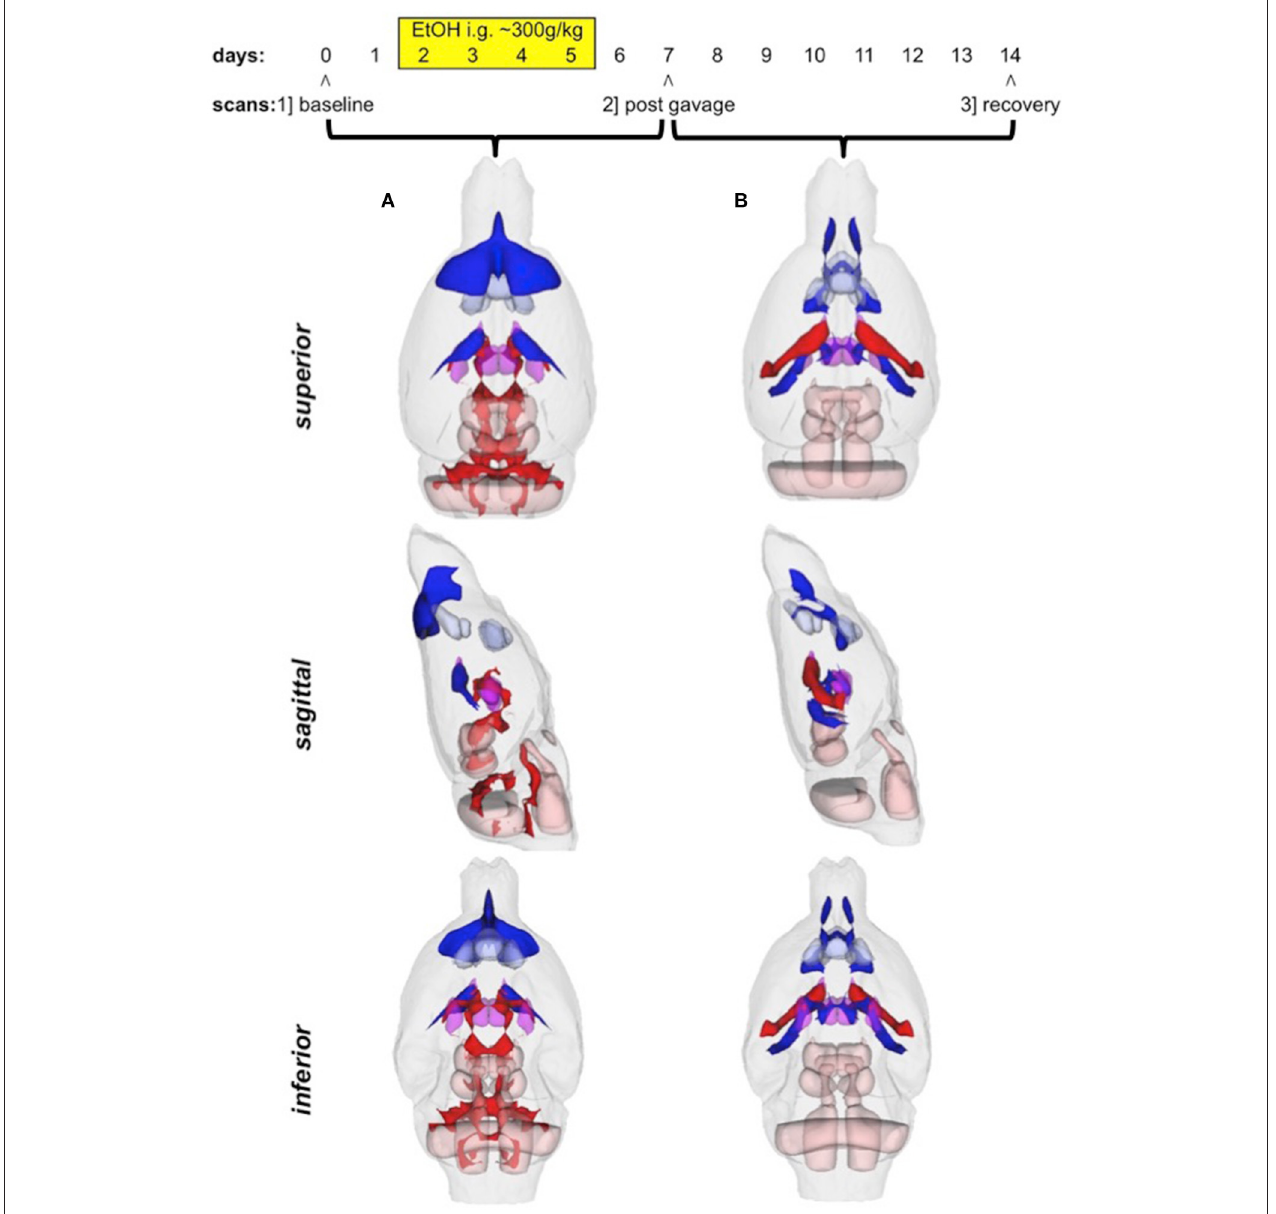
FIGURE 2 | (A) Voxels showing expansion (blue) and shrinkage (red) between baseline scan 1 and binge scan 2 superimposed on Figure 1 ROIs; (B) voxels showing expansion (blue) and shrinkage (red) between binge scan 2 and recovery scan 3 superimposed on Figure 1